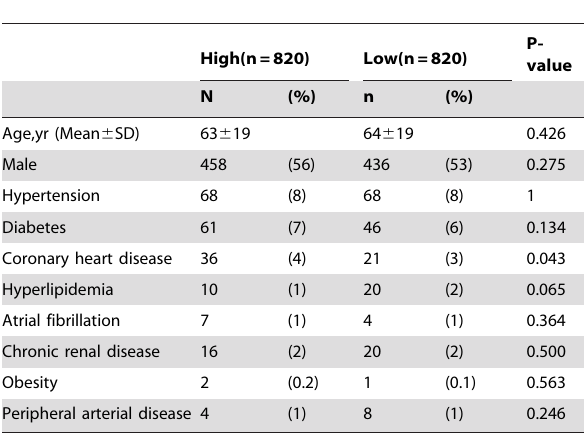
Table 7. Marginal effect of pneumococcal pneumonia on stroke event using instrumental variable analysis for one-year follow up